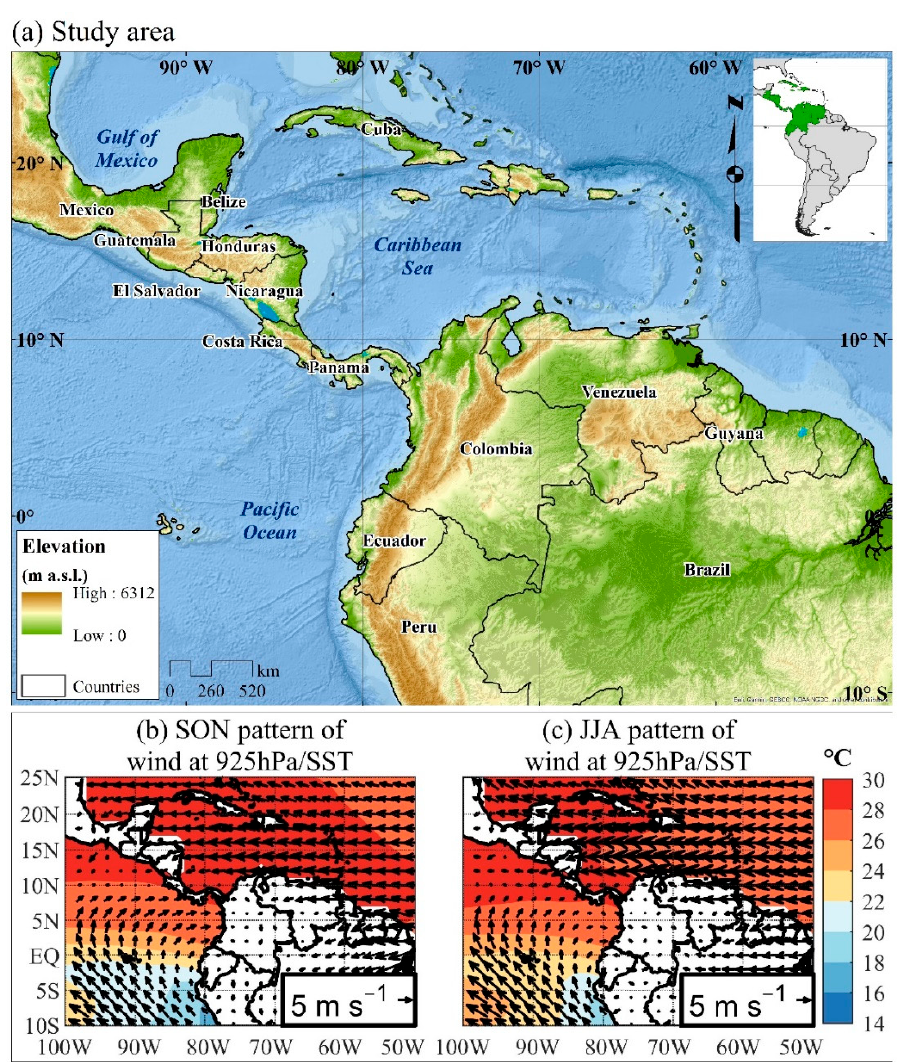
Figure 1. ( a ) Study area location. Elevation data were obtained from Shuttle Radar Topography Mission (SRTM), Available at http://www2.jpl.nasa.gov/srtm/ accessed on 26 August 2021; ( b ) SON pattern of wind at 925 hPa (m s − 1 ) and sea surface temperature (SST); and ( c ) JJA pattern of wind at 925 hPa (m s − 1 ) and SST.